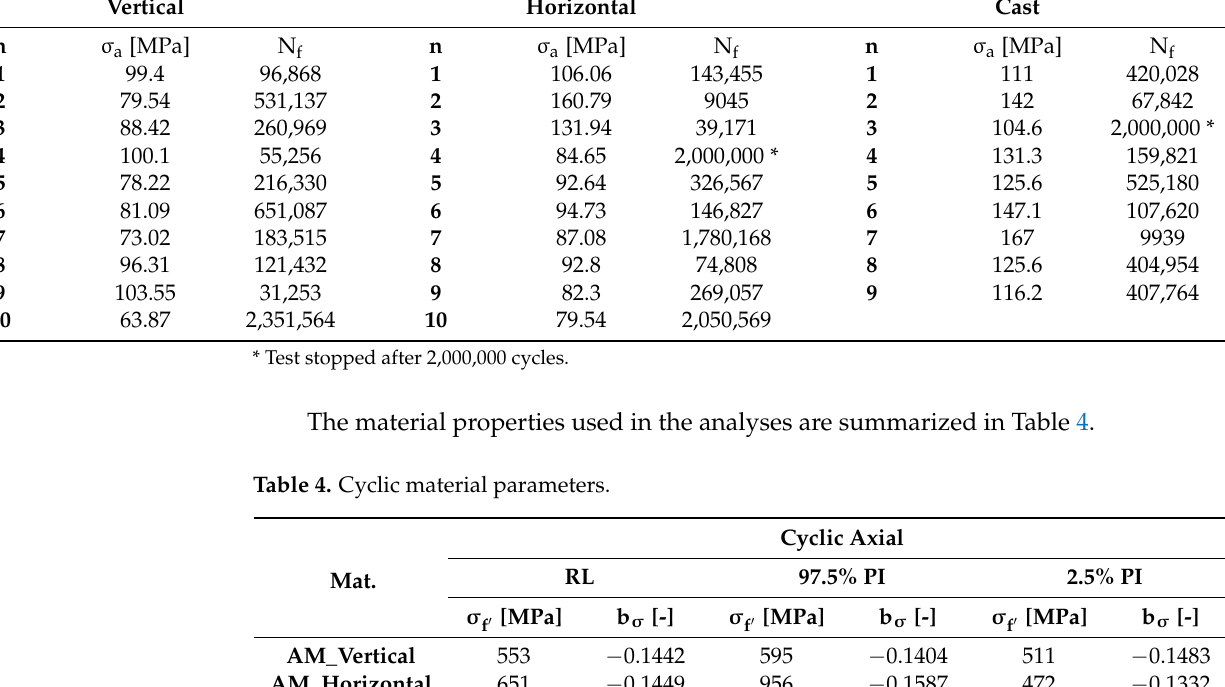
Figure 9. Comparison of Basquin curves for each analysed material. 2.2.2. Multiaxial Fatigue Assessment When estimating fatigue lifetime under multiaxial variable amplitude loading, sev- eral key aspects must be considered. The methodology that identifies individual loading cycles in multiaxial loading histories must be implemented. A multiaxial fatigue criterion which transforms the multiaxial stress state to the equivalent stress amplitude (compara- ble with the appropriate fatigue curve) must be chosen, with appropriate methodology that considers the nonproportionality of loading cycles. Finally, the damage accumulation rule must be used to accumulate the fatigue damage caused by each individual loading cycle. Cycle Counting Method Several cycle counting methods have been proposed and analysed by multiple au- thors [16–22]. The methodology described in [23] is used to identify the individual loading cycle for each selected obstacle. The cycle counting method is based on cycle identification in relative maximum shear stress histories (calculated from multiaxial loading histories)